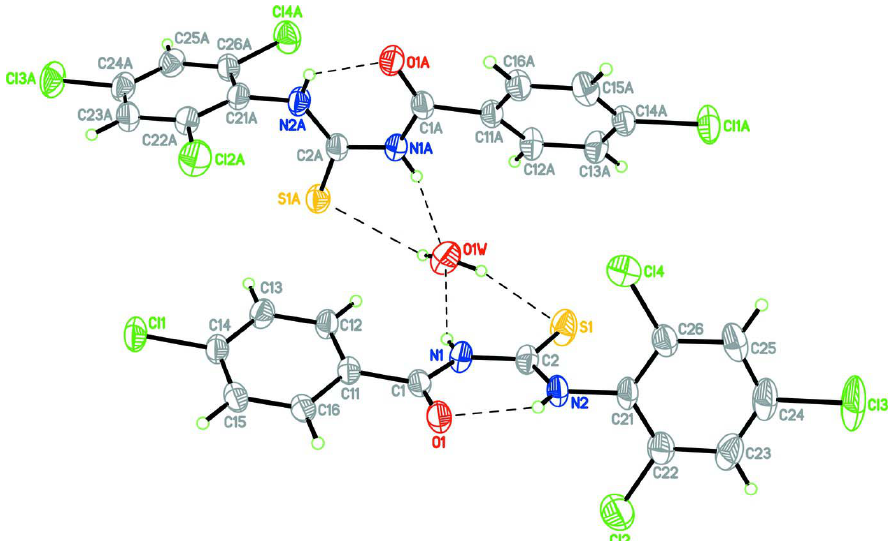
Figure 1 Molecular structure of (I) showing the atom numbering scheme. Intra- and intermolecular hydrogen bonds are shown as dash lines. Displacement ellipsoids are drawn at the 50% probability